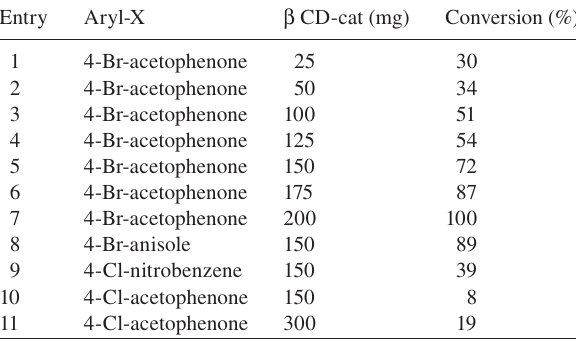
Table 2 Heck reaction: MW under pressure with different amount of β -CD/Pd (II)